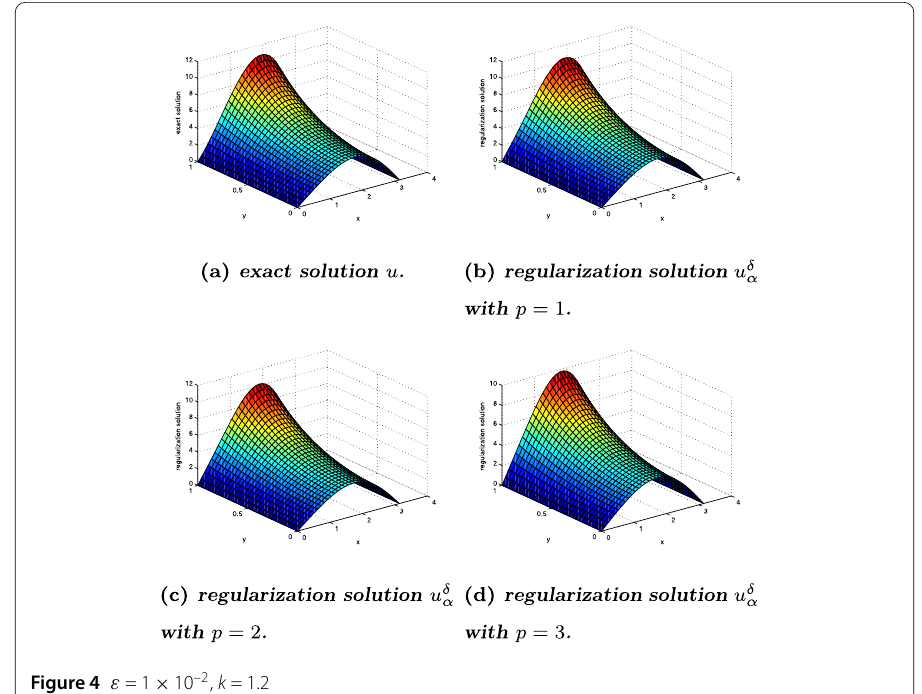
Figure 4 ε = 1 × 10 –2 , k = 1.2